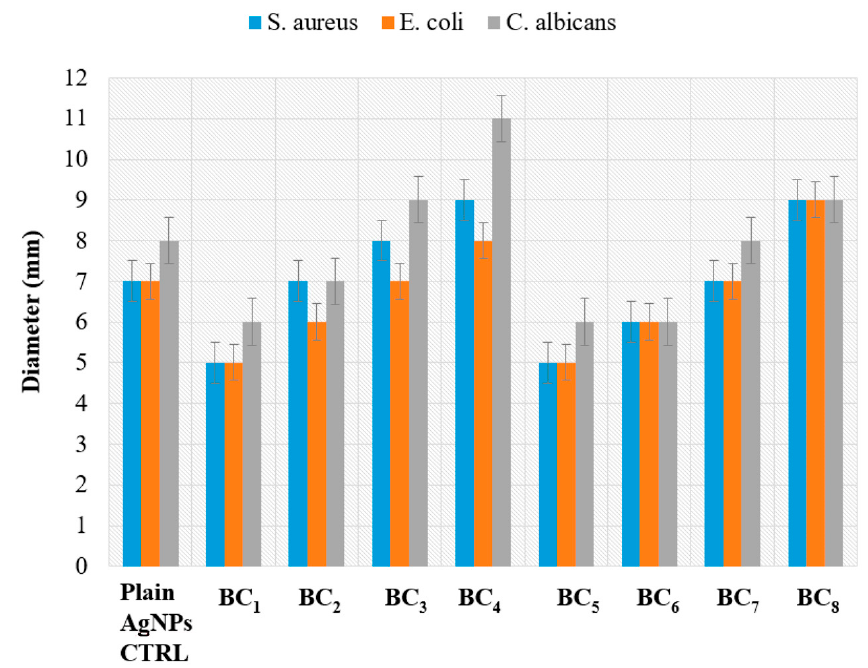
Figure 13. The diameter of the growth inhibition zone of the tested microorganisms grown in the presence of the obtained BC samples containing various amounts of AgNPs. The plain AgNP control is represented by 10 uL of AgNPs (used at maximum equivalent amount contained in BC samples), which was added to a commercial filter paper disc of a similar size as the obtained BC samples. Because composites BC 1 and BC 5 did not contain antibacterial AgNPs, they were used as control samples for evaluation of the other